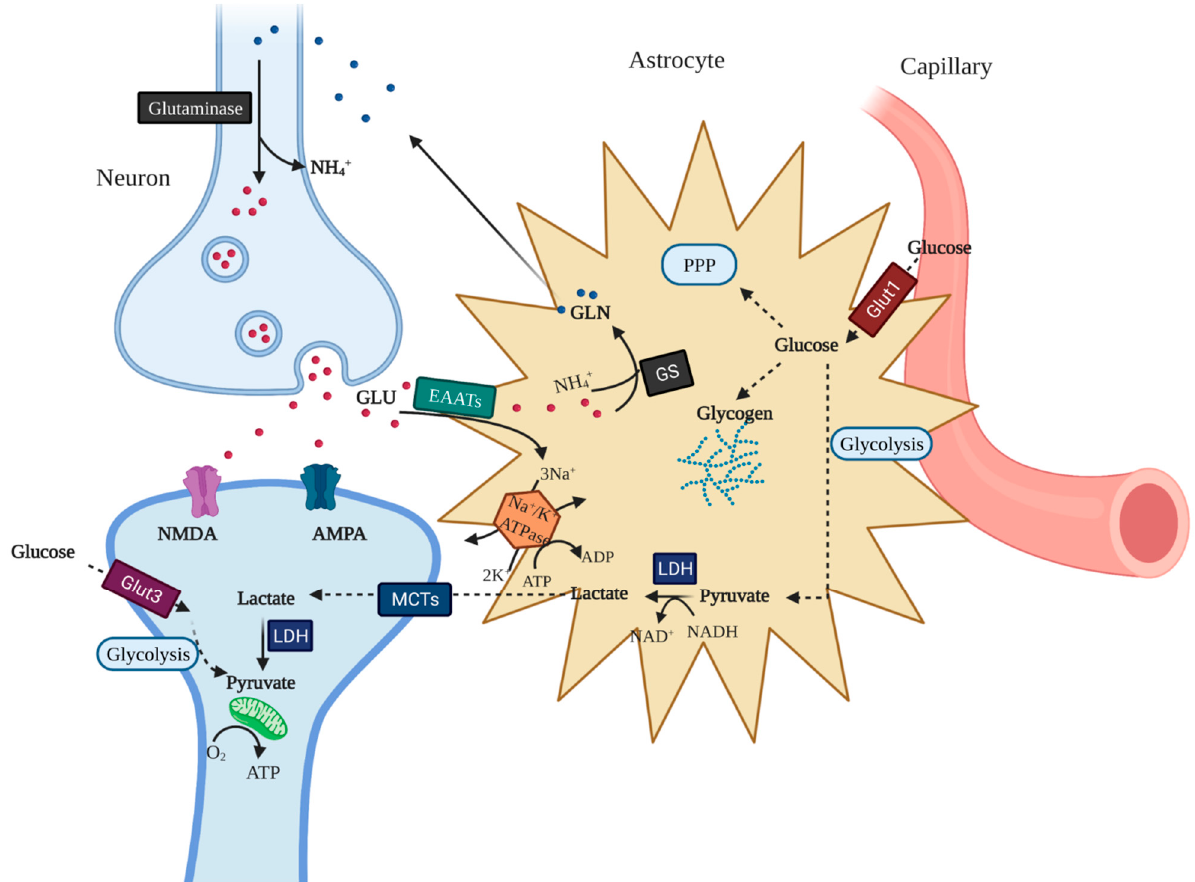
Figure 1. Interplay of glucose metabolism in neurons and astrocytes (created in